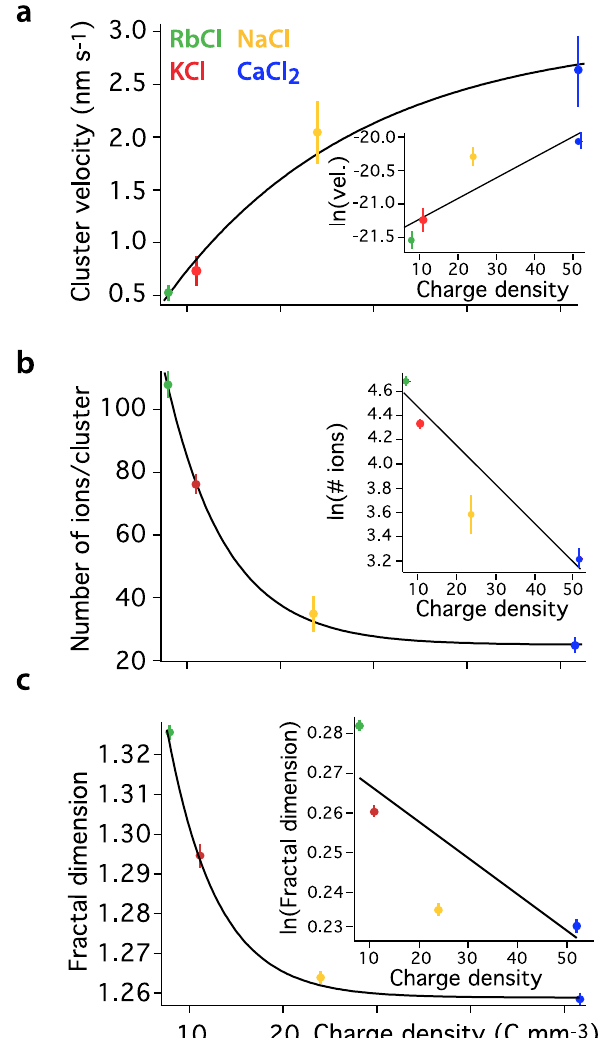
Figure 3. Dynamics of cationinc clusters at the interface. ( a ) The clusters’ mobility is calculated considering the average displacement of the cluster’s centre of gravity between consecutive frames. The average cluster velocity increases with ρ and can be modelled with an exponential behaviour. This is consistent with a hydration- dominated process whereby thermal fluctuations govern the adsorption/desorption of ions from the mica surface. More strongly hydrated ions are moved more easily due to a weaker adsorption when in outer sphere configuration 45 (see text). ( b ) The average number of ions per cluster decays exponentially with ρ , as does the average size of the cluster (see Fig. S4 within ESI Section 6). This suggests higher ρ to disfavour attractive water-mediated correlation interactions between ions 30 . Consistently, the fractal dimension ( c ) of clusters decays with ρ , reflecting the ability of ions with smaller ρ to create more complex cluster shapes due to stronger water- mediated attractive interactions (as visible in Fig. 1). The number of ions per cluster, the domain size and the fractal dimension are averaged over all the frames. ESI Section 7 provides further details on estimating fractal dimension. The insets in ( a – c ) suggest an exponential dependence on ρ